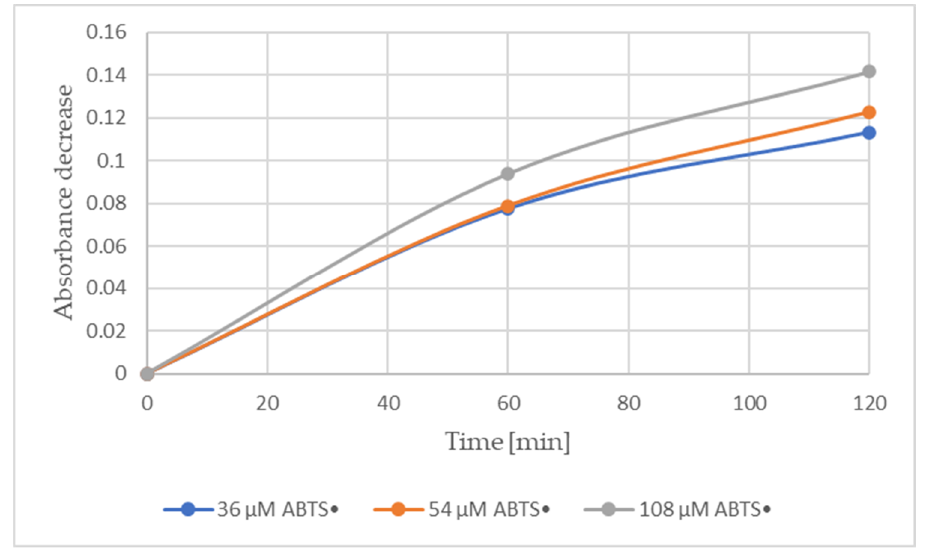
Figure 8. Absorbance decrease of ABTS • solutions with various initial concentrations.